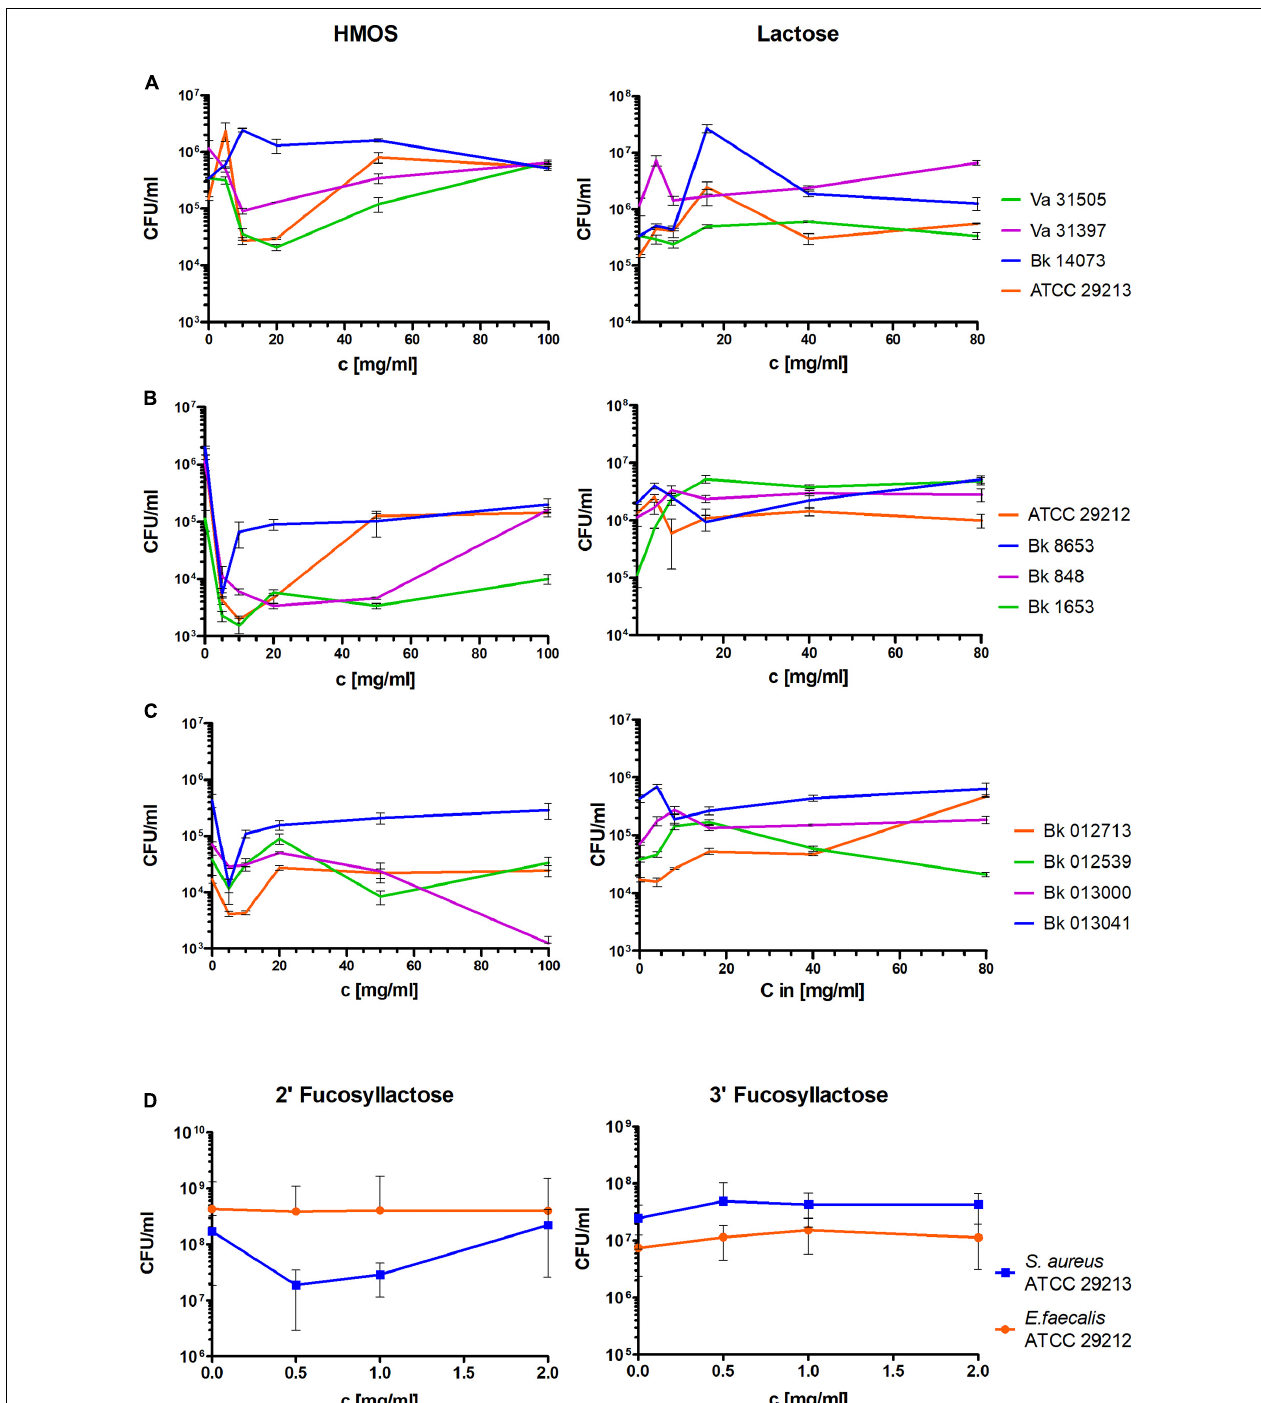
FIGURE 4 | Determination of the viable cell fraction (as CFUs/ml) in biofilms of laboratory standard and clinical strains of different Gram-positive species. (A–C) After treatment with the total HMOs and lactose in corresponding concentrations (assuming that lactose makes up 80% of the HMOs) for 24 h. (A) S. aureus , (B) E. faecalis , (C) E. faecium . (D) Activities of the FL isomers 2 (cid:48) -FL and 3 (cid:48) -FL against biofilms of S. aureus and E. faecalis expressed as CFU/ml after treatment. Data of three independent experiments performed in triplicate are given as mean and standard deviation (SD).